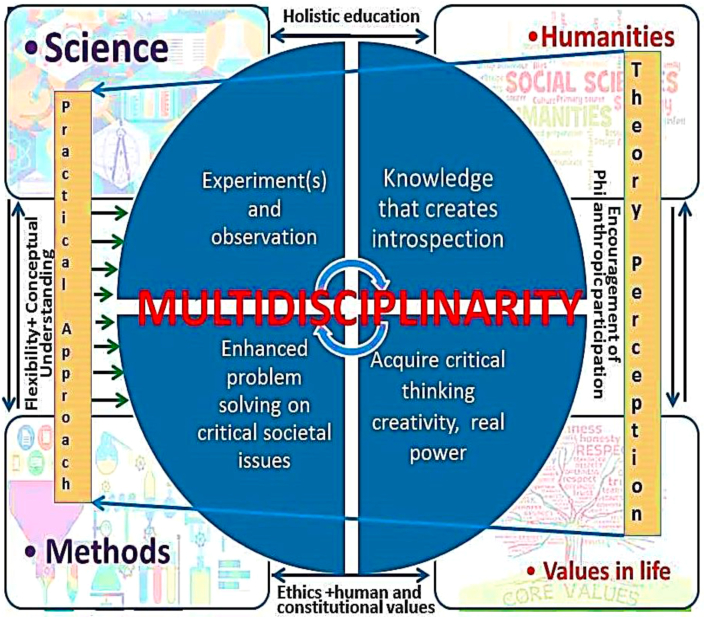
Model explaining the association between science and humanities in interdisciplinarity. Multidisciplinary may be set on the basis of contemporary and future societal needs that should lead to flexibility in holistic education and in turn it would develop ethics, constitutional values, creativity, critical thinking, problem solving, philanthropic participation in pupils. Multidisciplinary must primarily address the relationship between power and knowledge, and how they are used as a form of social control through societal institutions and a critical history of modernity for better problem solving of contemporary issues. All these could be better possible with multidisciplinary approaches rather than a disciplinary approach.